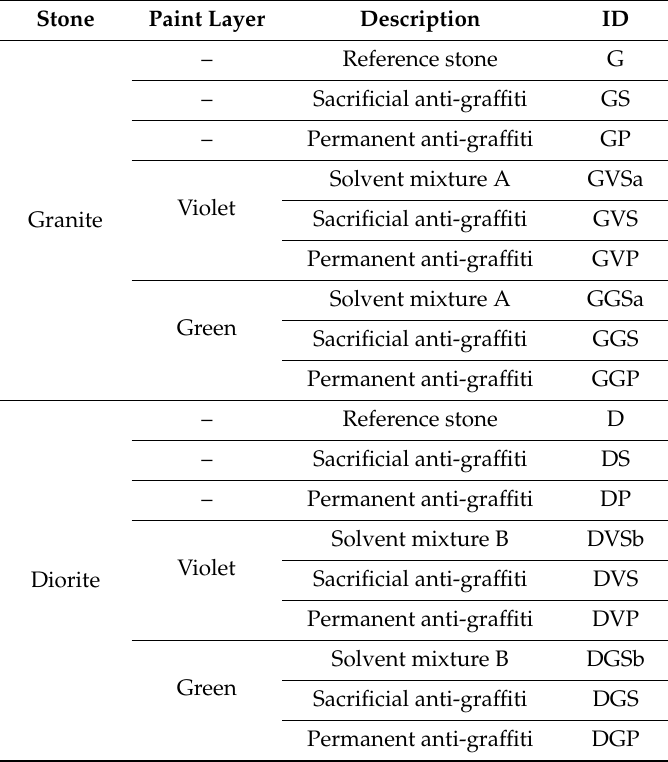
Table 1. Samples used in this research. Identification (ID) for each sample is also